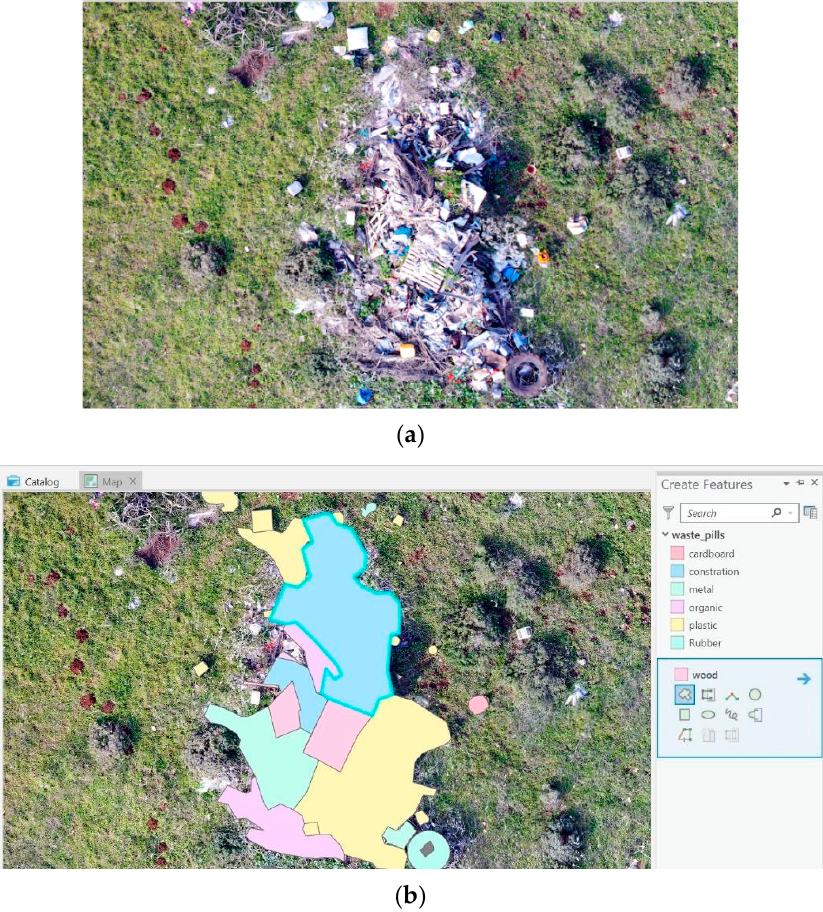
Figure 4. Orthophotos of illegal heterogeneous waste sites. Site #3—mixed waste dump; area 48.93 m 2 , volume 10.64 m 3 . Orthophoto ( a ) shows mixed waste, and orthophoto ( b ) shows the materials classification.